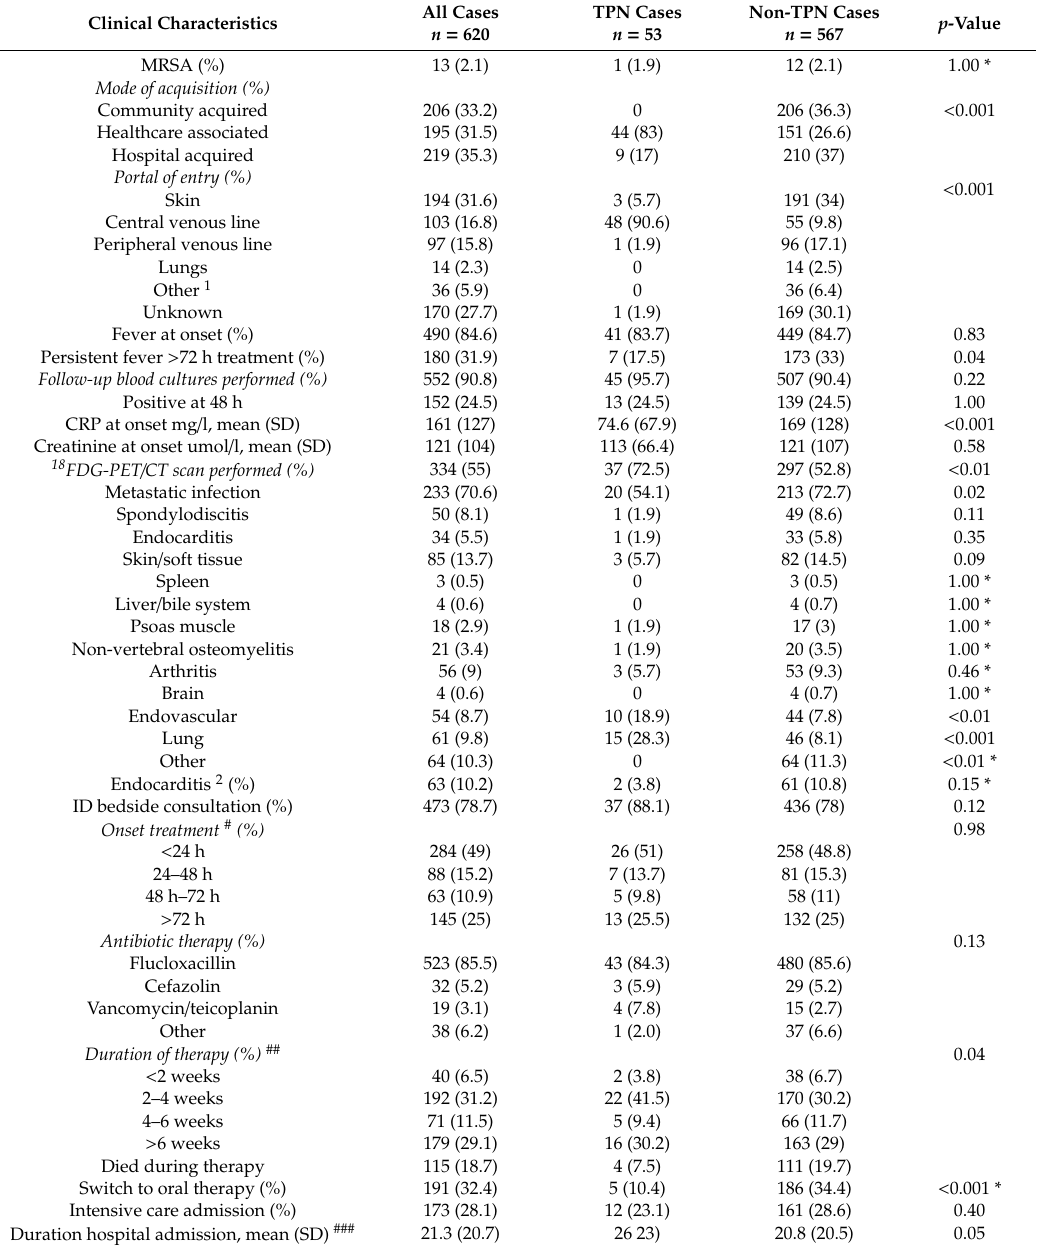
Table 2. Comparison of the clinical